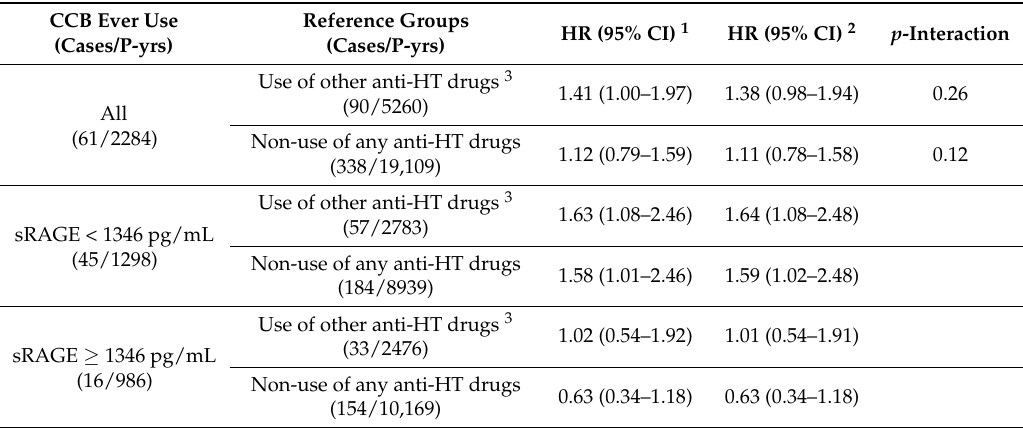
Table 4. Baseline CCB use status and risk of incident pancreatic cancer among participants with sRAGE measurements ( n =